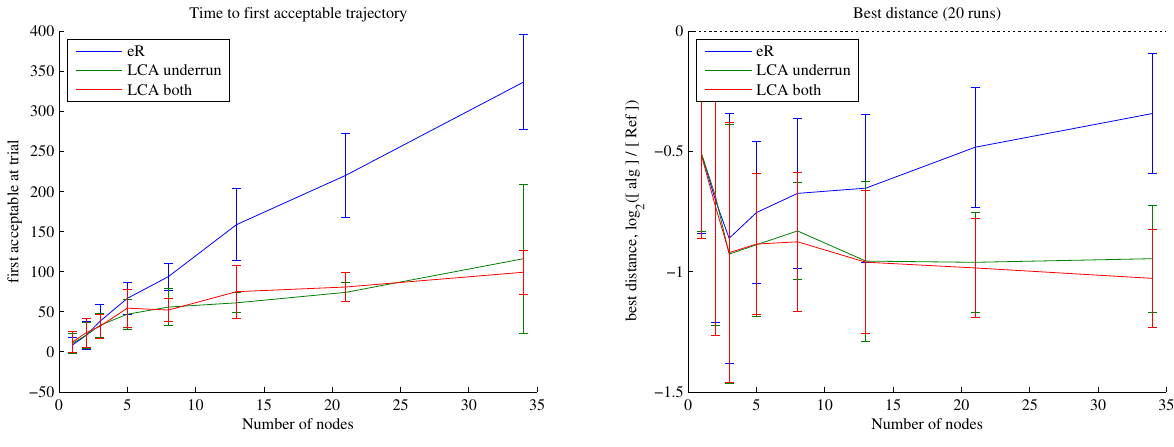
Figure 6. Waypoints trajectories with policy updates from the plain episodic REINFORCE (eR) gradient estimate only, from eR (weight 1) and underrun-only LCA estimate with = 5 , and LCA estimates for both underrun ( δ = 5 ) and length (weight 1), without weight δ u u the eR gradient. The UA is informed that the sensors are deployed along an east-west line with a spacing of 25 units, but each sensor’s actual position is displaced ± 10 units in a random direction. Three waypoints per node are initialised uniformly along the east-west line. Learning terminated upon discovery of an acceptable trajectory, so “best distance” is first acceptable